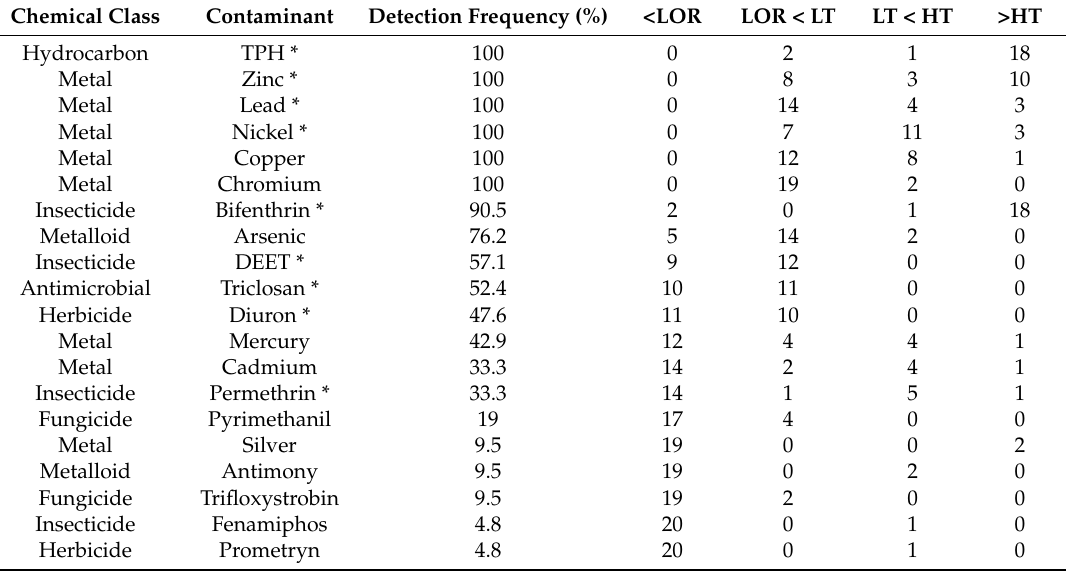
Figure 1. Location of 21 wetlands sampled in the Greater Melbourne Area. Including a visual representation of modelled ( a ) metal and hydrocarbon and ( b ) pesticide contamination at each location. Contaminant concentrations are displayed relative to ecological thresholds as described previously [34,35]. The size of each wheel represents the summed relative toxicity of presented contaminants for each map. Table 1. Contaminants that were frequently detected in wetland sediments. Entries provide the detection frequency (%) and the number of sites (out of 21) where each contaminant was below Limit of Reporting (<LOR), above LOR and below the Low Threshold (LOR < LT), above Low Threshold and below the High Threshold (LT < HT) and above the High Threshold (>HT). Thresholds have been defined previously [34,35]. Contaminants selected for random forest models are indicated with